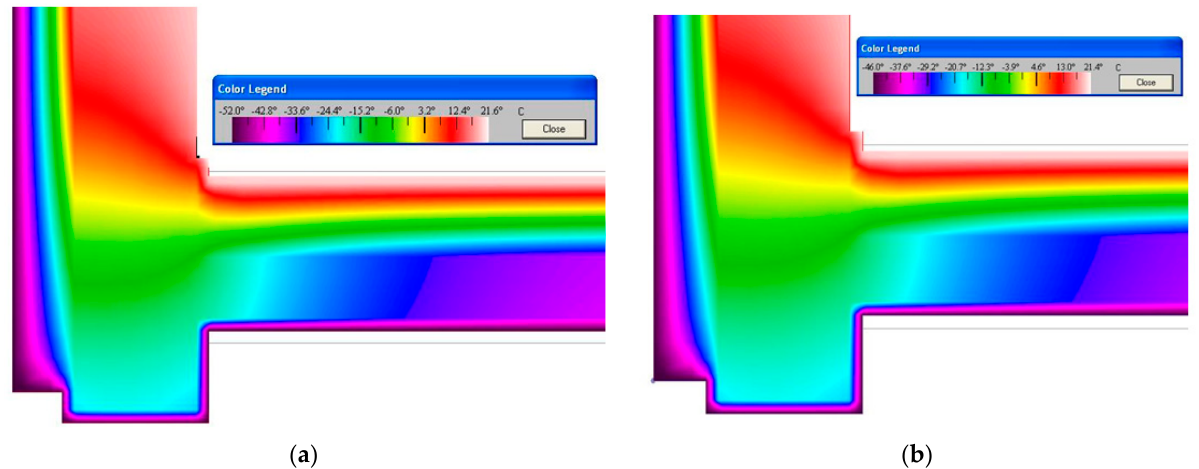
Figure 11. The structure of the formation of the temperature field in a structure isolated above the ventilated space (between the supporting columns): ( a )—visualisation of the temperature field for Yakutsk ( − 52 °C); ( b )—visualisation of the temperature field for Norilsk ( − 46 °C).